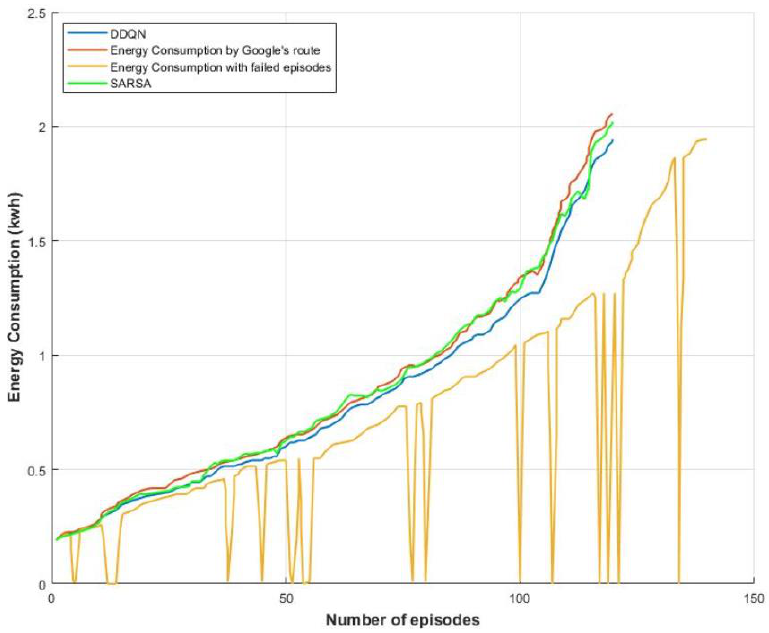
Figure 7. Benchmarking of the energy requirement for the second route for SARSA vs. DDQN and Google Maps.